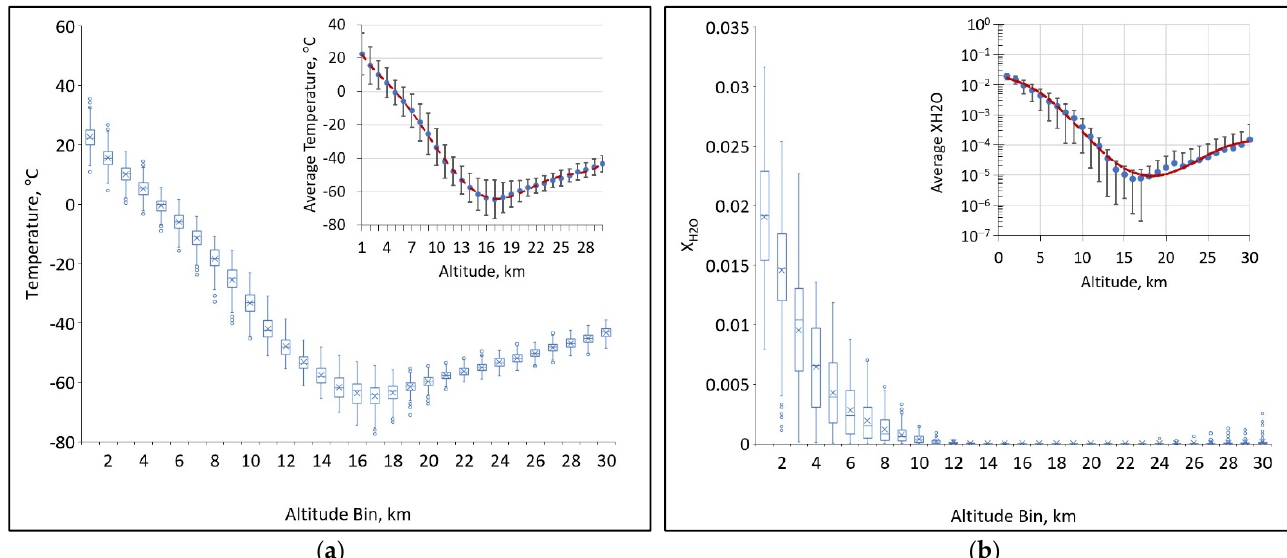
Figure 4. Extracted temperature and water profiles sorted into 1 km bins to visualize distributions at different altitudes. The insets show ( a ) average temperature and ( b ) average log 10 (X H2O ) with 1 σ deviations shown as vertical bars and 6th order polynomial fits for data over the decade-long, 7-day window.